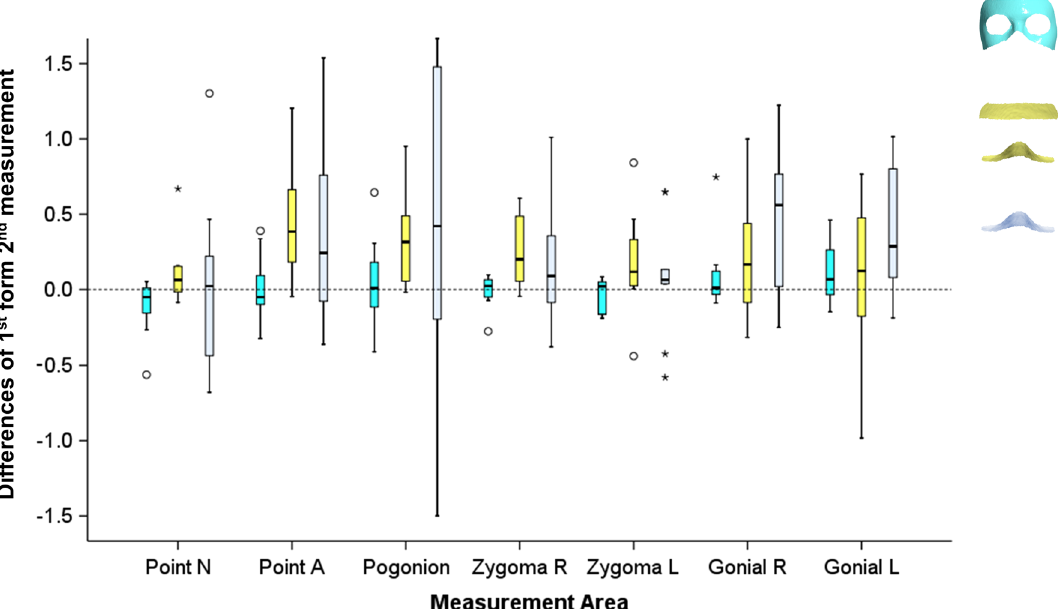
Figure 6. Box plots showing in the y-axis the differences between repeated facial surface model segmentation and superimposition on three references areas. The dashed horizontal line indicates zero, and thus, perfect reproducibility. The upper limit of the black line represents the maximum value, the lower limit the minimum value, the box the interquartile range, and the horizontal black line the median value. Outliers are shown as black circles or asterisks, in more extreme cases, with a step of 1.5 × IQR (interquartile range). The vertical length of each plot indicates